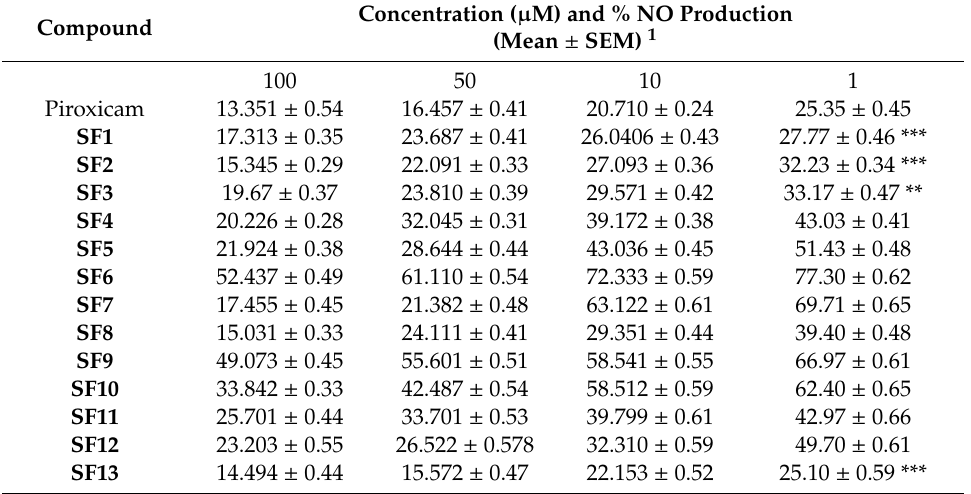
Table 6. Nitric oxide scavenging activity of synthesized compounds at different concentrations. Compound